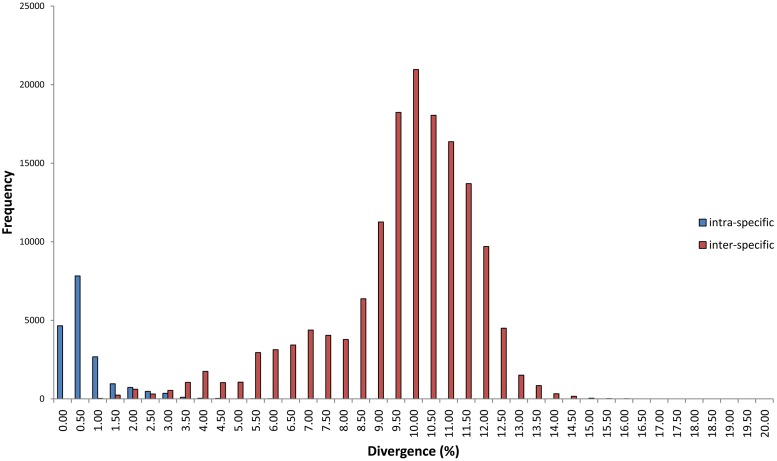
Frequency distribution of intraspecific and interspecific (congeneric) sequence divergence at COI in Pyraustinae involving17,832 intraspecific and 150,331 interspecific comparisons across 103 species.Divergences were calculated using the Kimura-2-parameter (K2P) model.